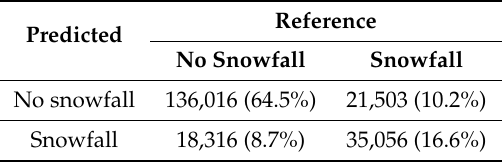
Table 3. Confusion matrix for the RF algorithm: total number of cases with the percentage values in